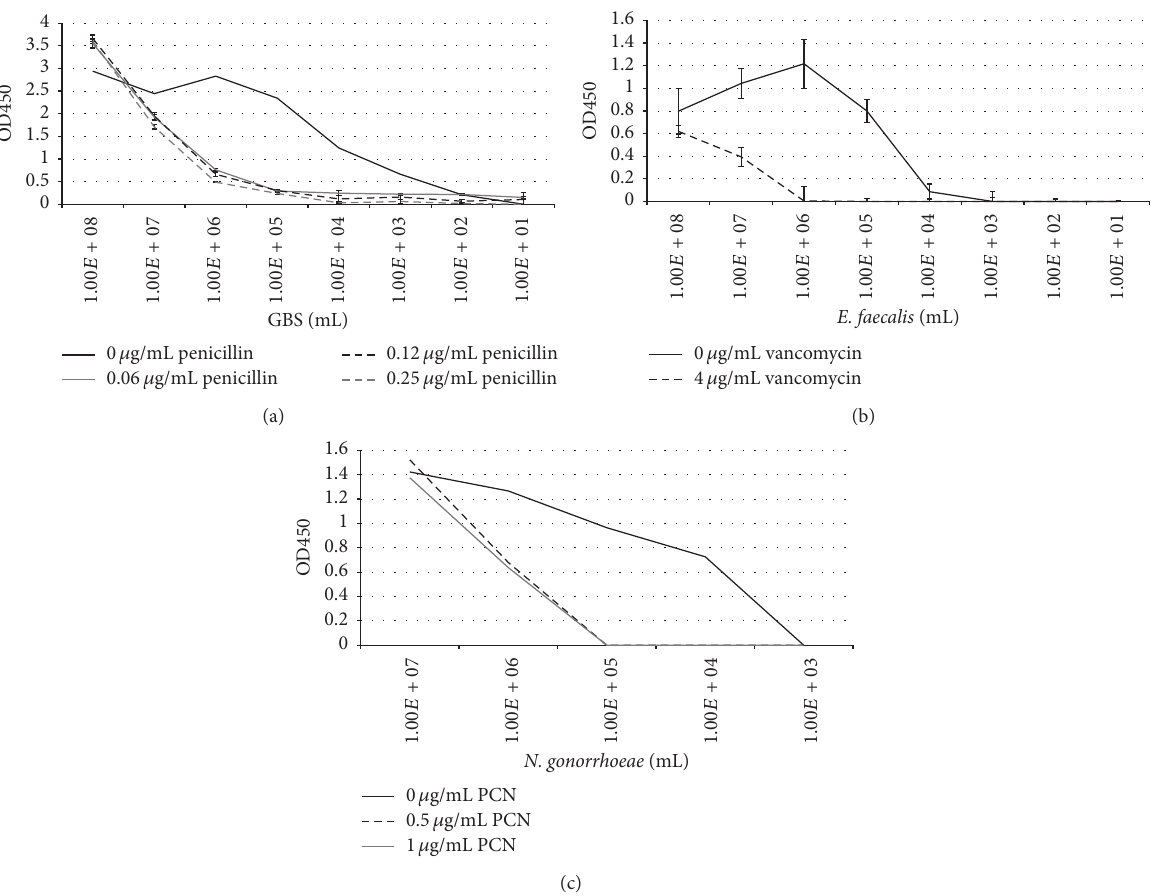
Figure 3: Bacterial identification and demonstration of susceptibility to selected antibiotics following a 6-hour culture. After first preparing a 0.5 McFarland in Fastidious Broth and then diluting bacterial isolates out, antibiotics were added to the wells giving the final concentrations indicated. (a) Dilutions of GBS strain 12386 (confirmed to be susceptible to penicillin by disk diffusion), in the presence of 0, 0.06, 0.12, or 0.25 𝜇 g/mL penicillin. (b) E. faecalis was diluted out in Fastidious Broth in the presence (4 𝜇 g/mL) or absence of vancomycin. Enterococcus faecalis ATCC strain 29212 was confirmed to be susceptible to vancomycin by disk diffusion. (c) N. gonorrhoeae was prepared and diluted out, as above, in 0, 0.5, or 1 𝜇 g/mL penicillin. Strain 1279, a clinical isolate of N. gonorrhoeae , was shown to be susceptible to penicillin by disk diffusion. Each test was performed in triplicate and data shown are representative of three individual experiments. Again, bacterial concentrations were confirmed by CFUs following plating on agar for 24–48